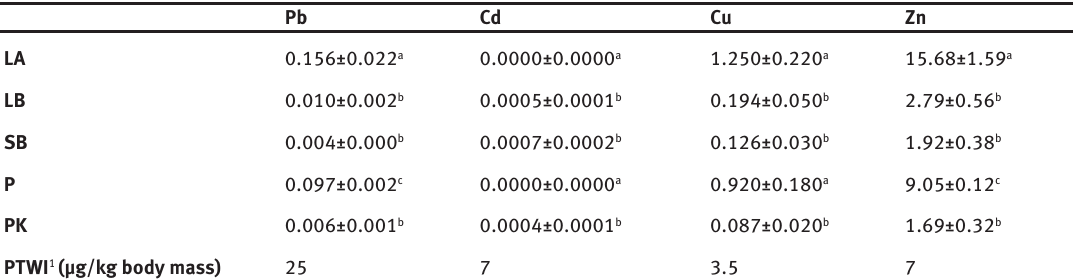
Table 3: Content of lead, cadmium, copper and zinc [mg/kg product] in kefir from various regions of Poland.